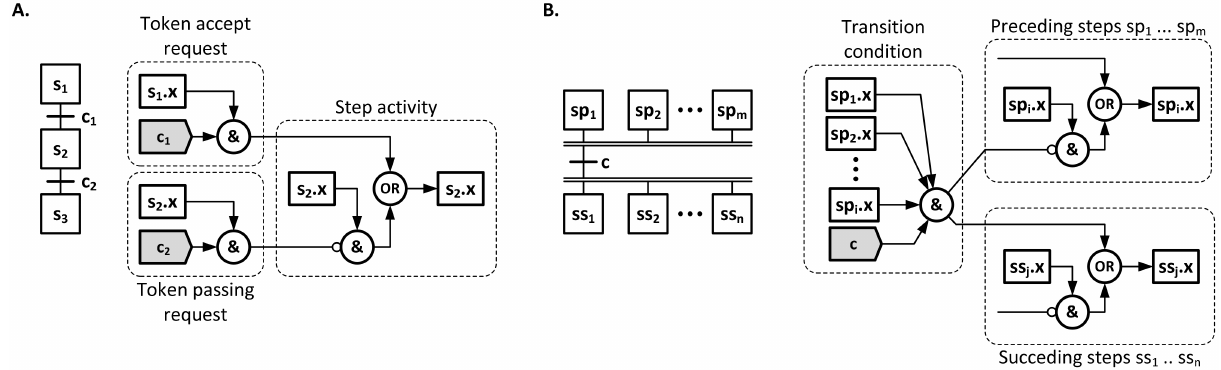
Figure 7. Steps of SFC general mapping concepts to EFG: step activity control ( A ) and general token passing concept between multiple steps ( B